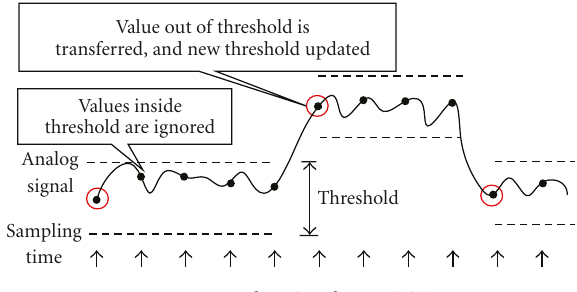
Figure 8: Analog signals